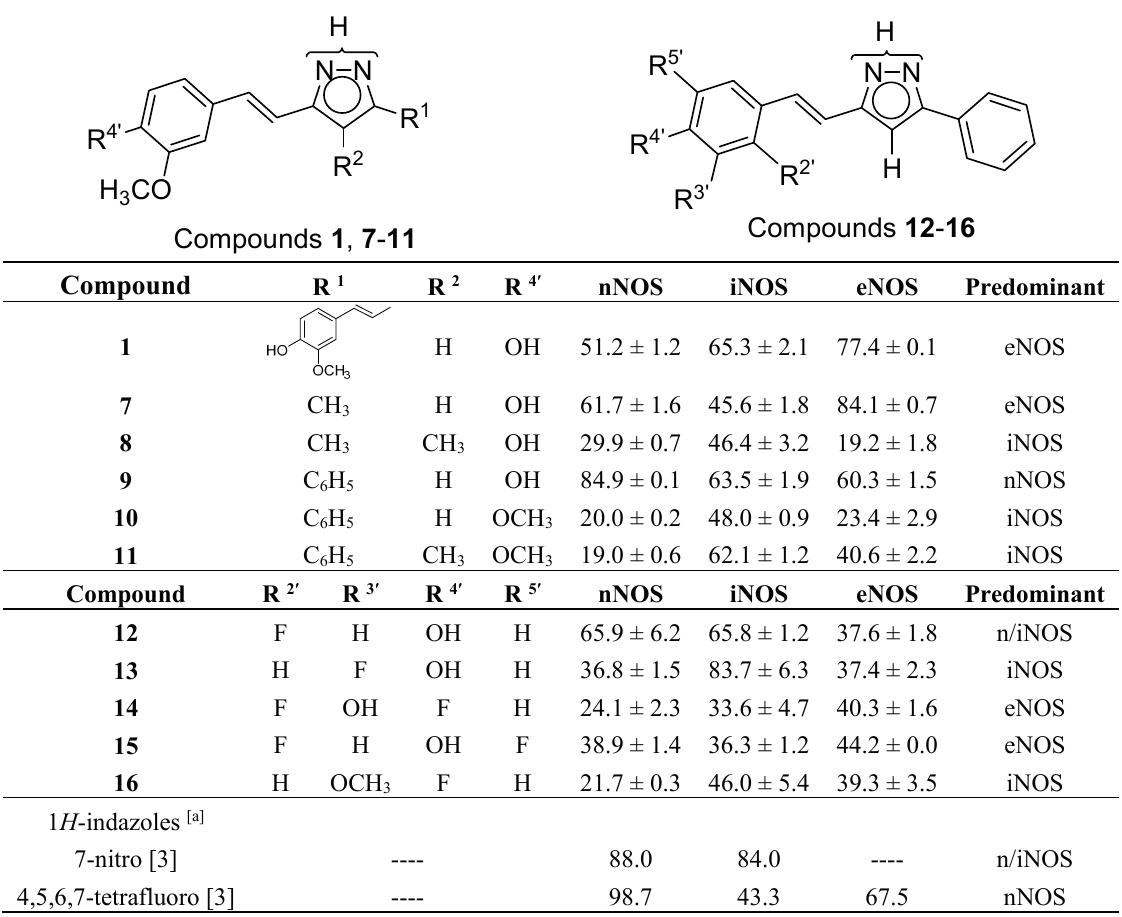
Table 4. Percentage of inhibition of nNOS, iNOS and eNOS activities in the presence of the tested curcuminoid pyrazoles 1 , 7 – 11 using 1 mM/EtOH and curcuminoid pyrazoles 12 – 16 using 50 μ M/DMSO, with the most interesting values in bold. Both series compared to control (0% inhibition). Experimental data represent the means ± S.E.M. of three independent experiments ( n = 3) each one performed in